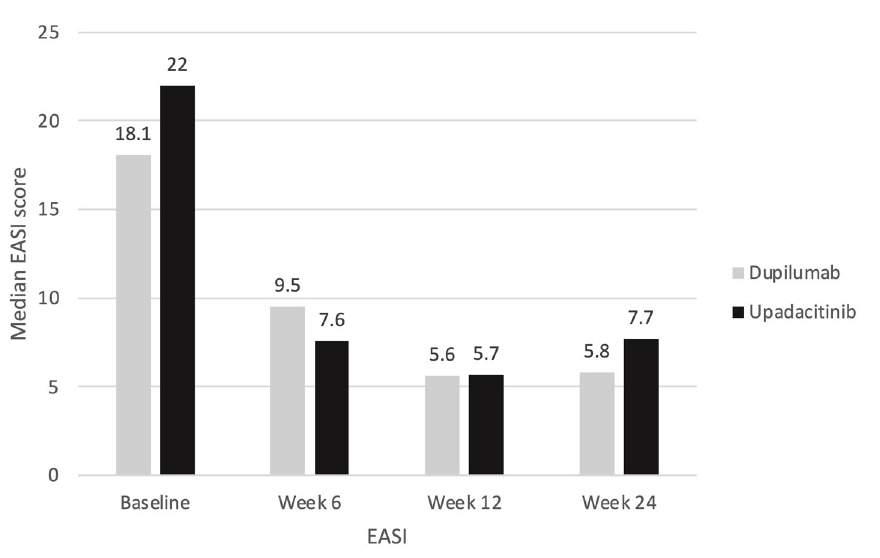
Figure 4. Median EASI score; p -value in Mann–Whitney U test for dupilumab ( n = 16) vs. upadaci- tinib ( n = 7) subgroup comparison (all time p > 0.05). ( n = 7) subgroup comparison (all time p >